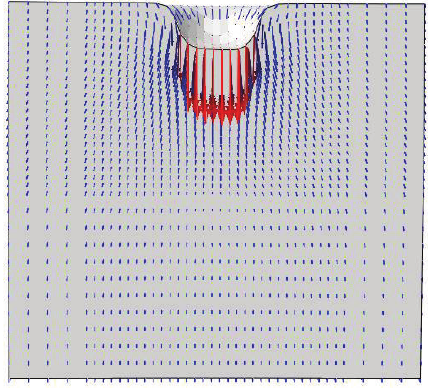
Figure 28: Penetration deformation calculated when 𝐷 𝑟 = 60 %, V = 4 m/s, and 𝑚 = 6 kg.